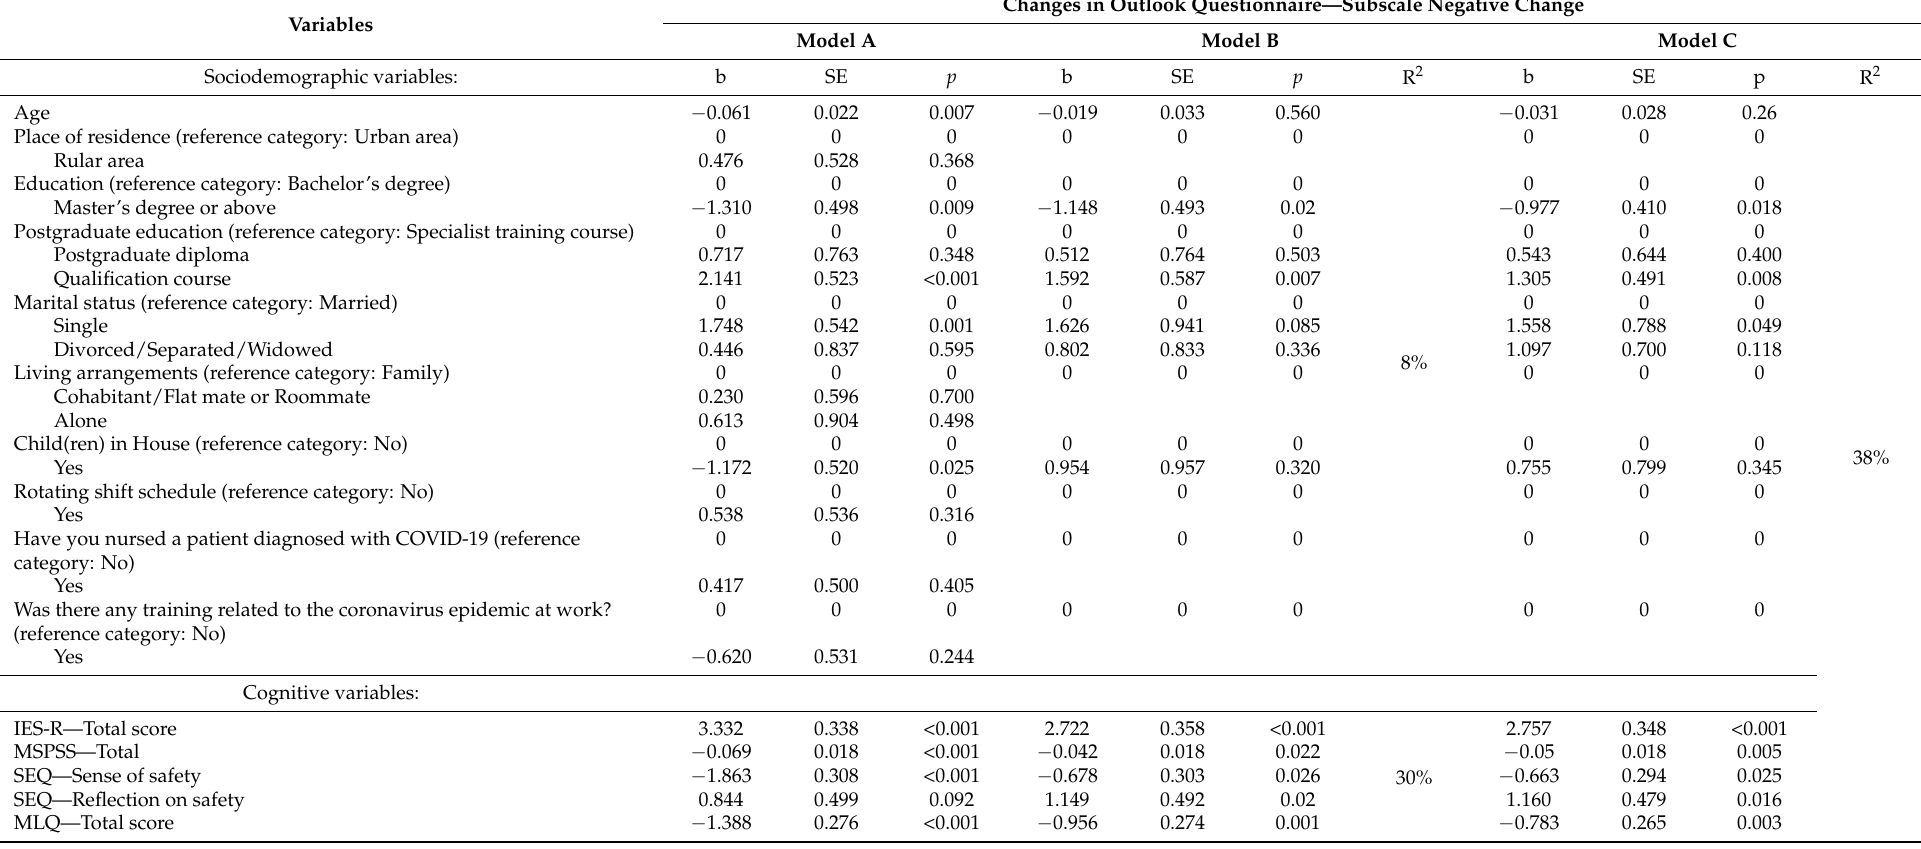
Table 5. Relationship between the negative perspective of the COVID-19 pandemic and selected sociodemographic and cognitive variables.